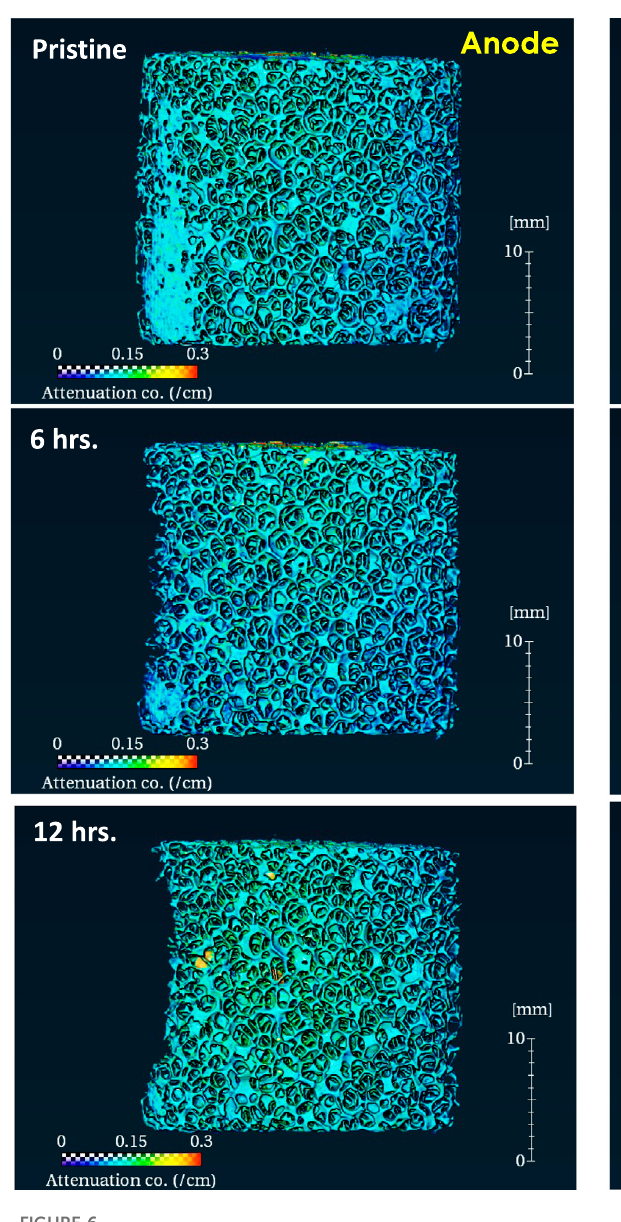
FIGURE 6 Reconstructed 3D volume of porous Al foam electrodes (small pores) before and after 6-hours and 12-hours electrocoagulation